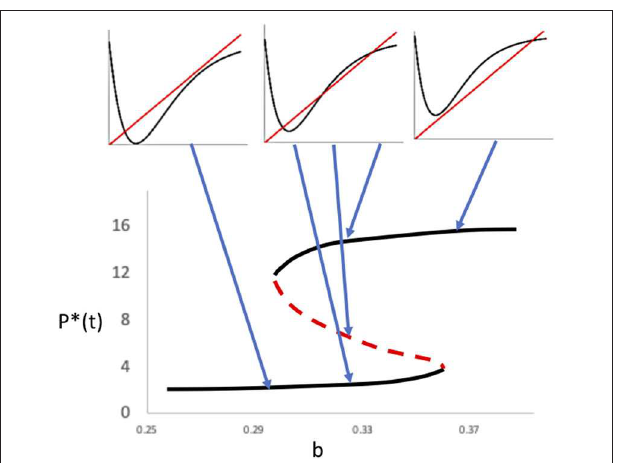
FIGURE 8 | Critical transition and hysteresis emerging from the dual saddle/node bifurcations.